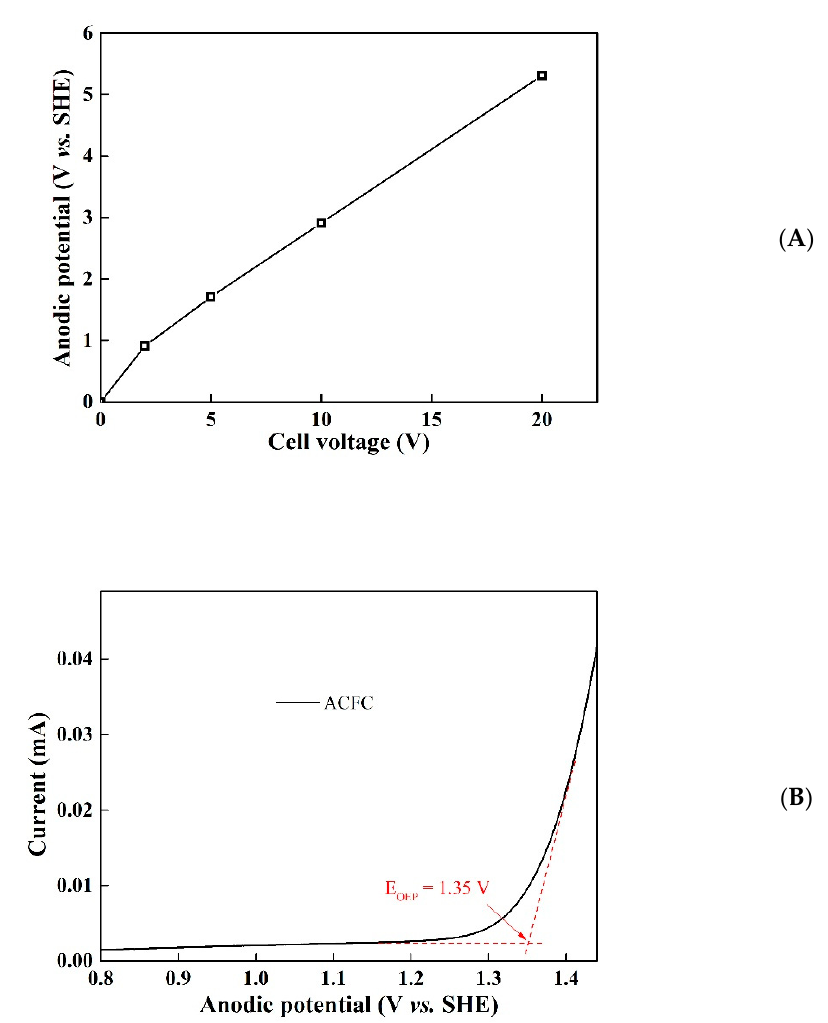
Figure 5. ( A ) The anodic potential vs. SHE (V) at different cell voltage; ( B ) Linear scan voltammetry of ACFC in 50 mM Na 2 SO 4 solution at the scanning rate of 50 mV s − 1 .